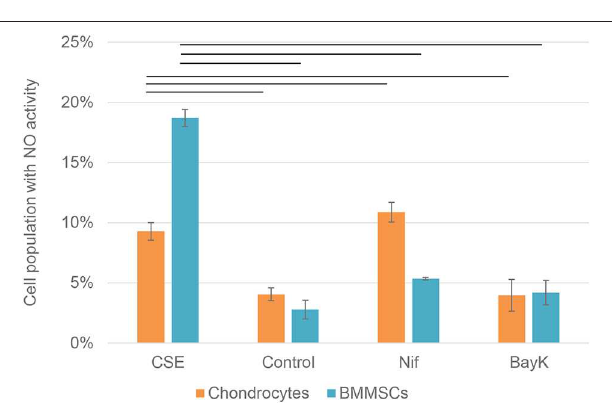
FIGURE 10 | Chondrocyte and BMMSC dead cell population after treatment with cigarette smoke extract (CSE) (1 µ g/mL), nifedipine (10 µ M) (Nif), BayK8644 (10 µ M) (BayK) for 24h; 7-AAD (flow